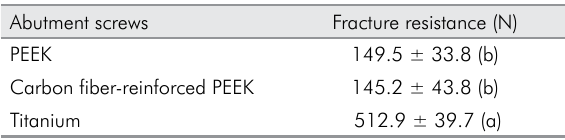
Table 1. Fracture resistance of abutment screws (mean ± standard